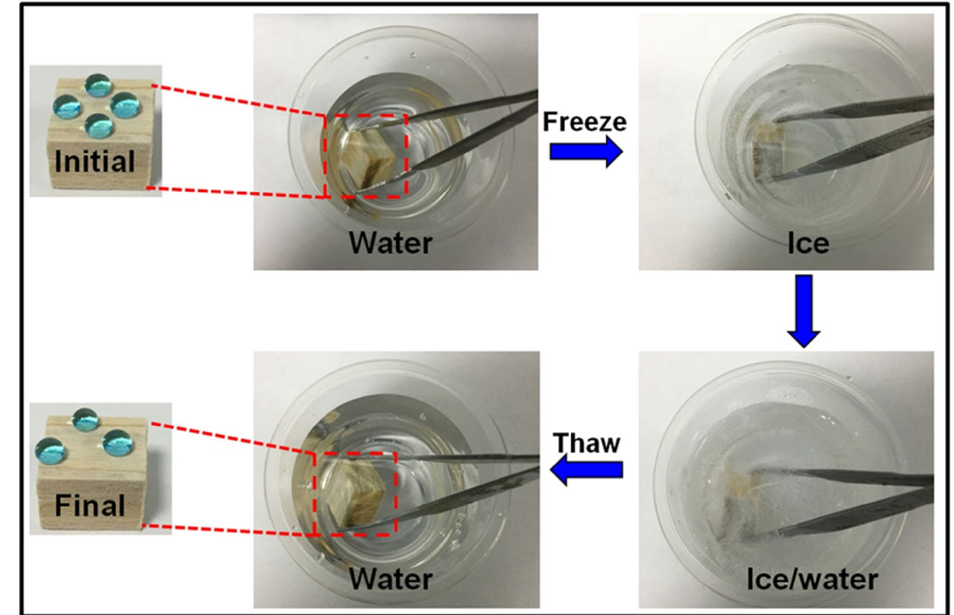
Figure 8. Anti ‐ icing test of the SiO 2 /PMHOS ‐ treated wood.